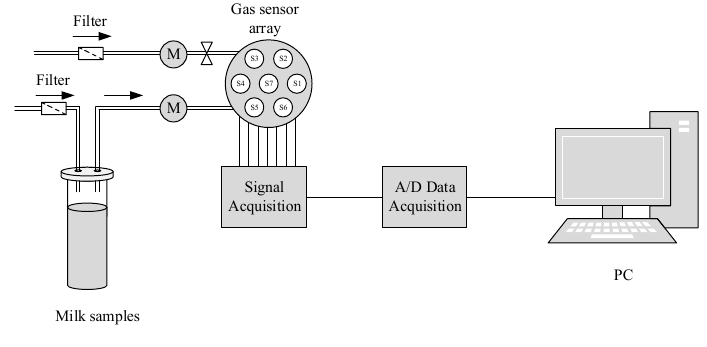
Figure 2. E-nose detection structure.